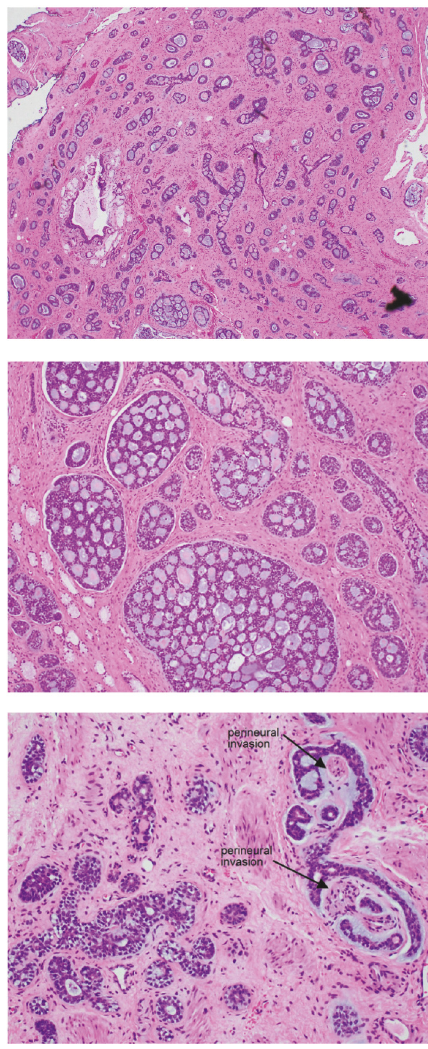
Figure 2: Histological slide of the ACCBG specimen. Cribriform and tubular glands infiltrating the submucosa of the vulva. There are pseudoglandular spaces with excess basement membrane material and mucin. Foci of perineural invasion are present. The tumour involves excision